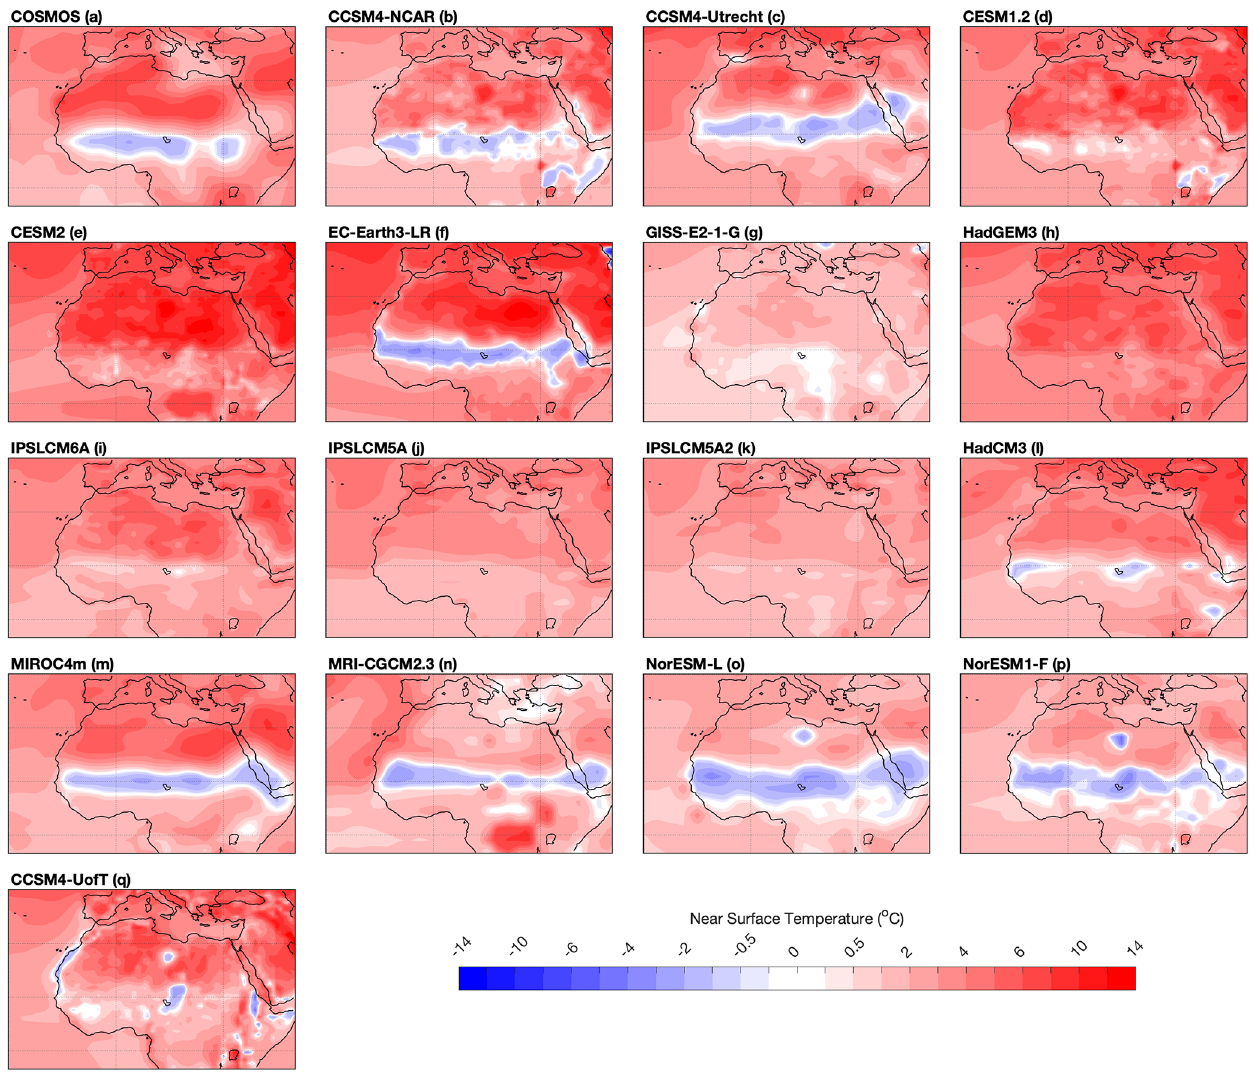
Figure 6. July–October (JASO) mean near-surface temperature anomalies ( (cid:49) SAT, mPWP-PI) for the PlioMIP2 ensemble members (a–q)